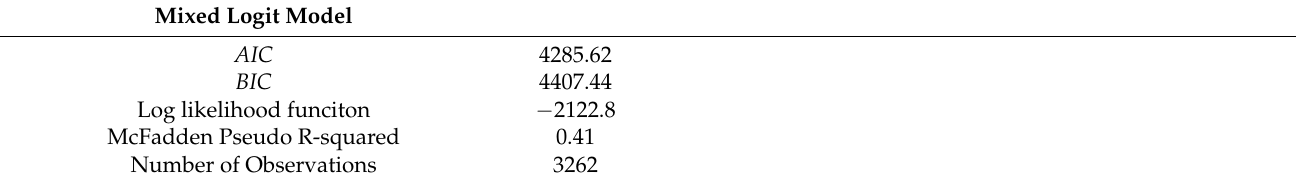
Table 4. Results of truck model